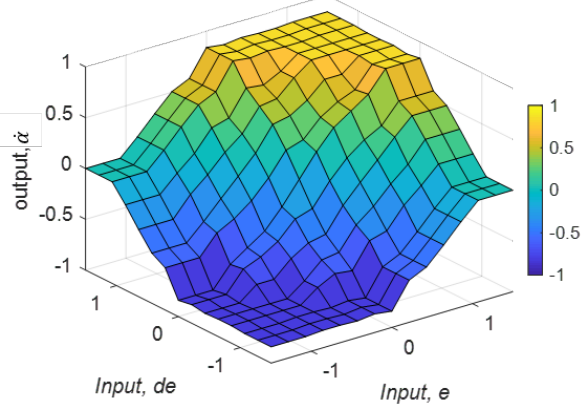
Figure 16. The decision surface of the fuzzy logic